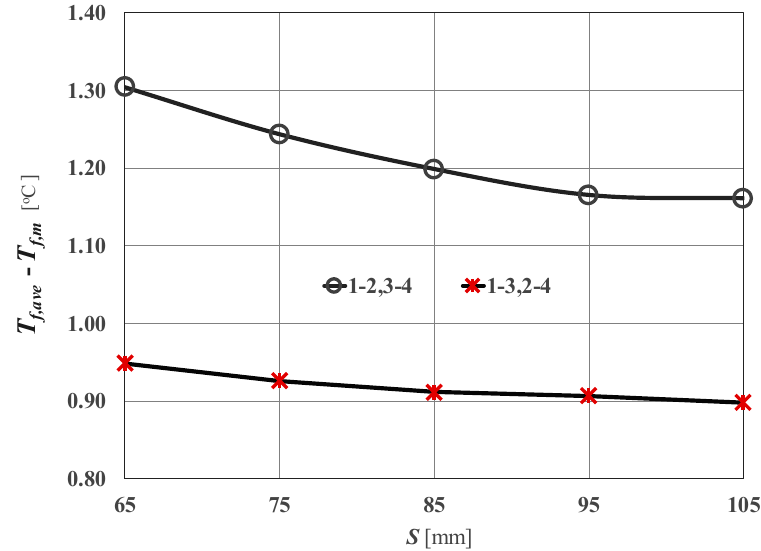
Figure 9. Deviation of the mean fluid temperature from the average fluid temperature versus shank spacing at t = 100 h.